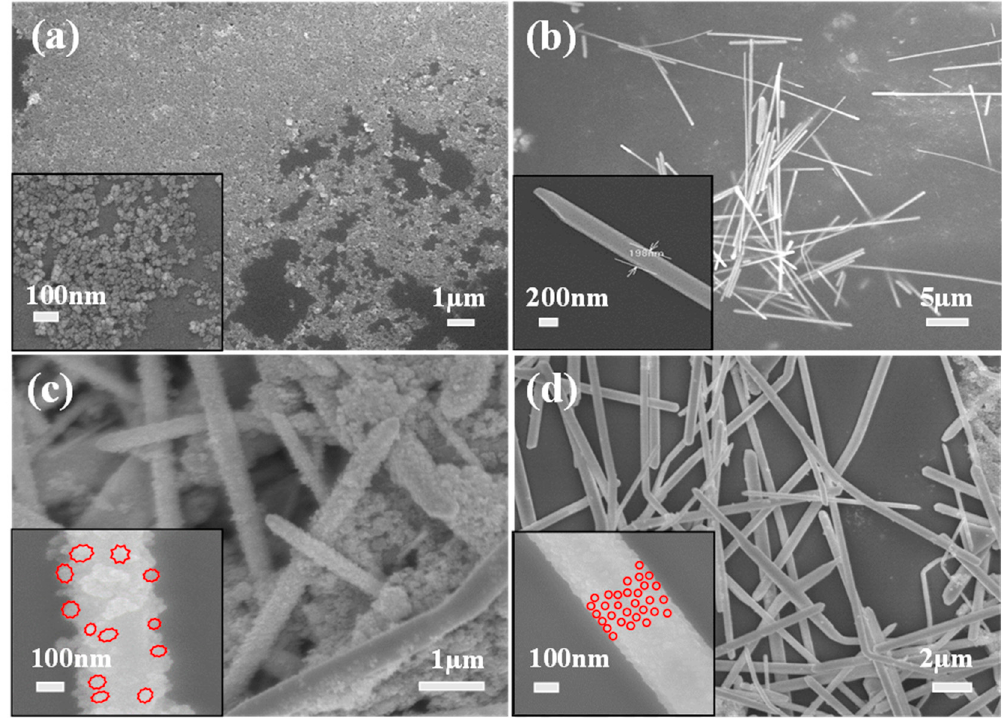
Figure 2. SEM images of ( a ) as-synthesized ZnFe 2 O 4 NPs coated with PVP, ( b ) pure AgNWs, ( c,d ) ZnFe 2 O 4 @AgNWs hybrid nanostructures with different weight ratios: ( c ) ZnFe 2 O 4 NPs:AgNWs = 1:2, ( c , d ) ZnFe 2 O 4 @AgNWs hybrid nanostructures with di ff erent weight ratios: ( c ) ZnFe 2 O 4 ( d ) ZnFe 2 O 4 NPs:AgNWs = 1:6. The red contours in the insets of ( c , d ) represent the general shapes of ZnFe 2 O 4 NPs deposited on the surface of AgNWs.